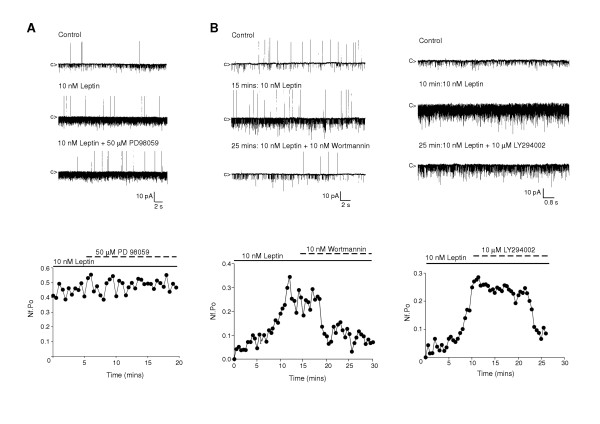
PI3K activity mediates leptin activation of KATP Representative cell-attached recordings with leptin (10 nM), present in the recording electrode. A, traces illustrate that leptin-induced increase in KATP activity is not reversed on bath application of the MEK inhibitor, PD 98059 (50 μM). The corresponding diary plot for part of the recording, initiated 20 mins after recording began, and following attainment of maximal leptin-induced KATP channel activity is shown. B, traces show that leptin-induced KATP channel activity is inhibited by subsequent application of the PI3K inhibitors, wortmannin (10 nM) or LY294002 (10 μM). Corresponding diary plots for Nf.Po from a single experiment for each PI3K inhibitor are shown below the relevant traces.